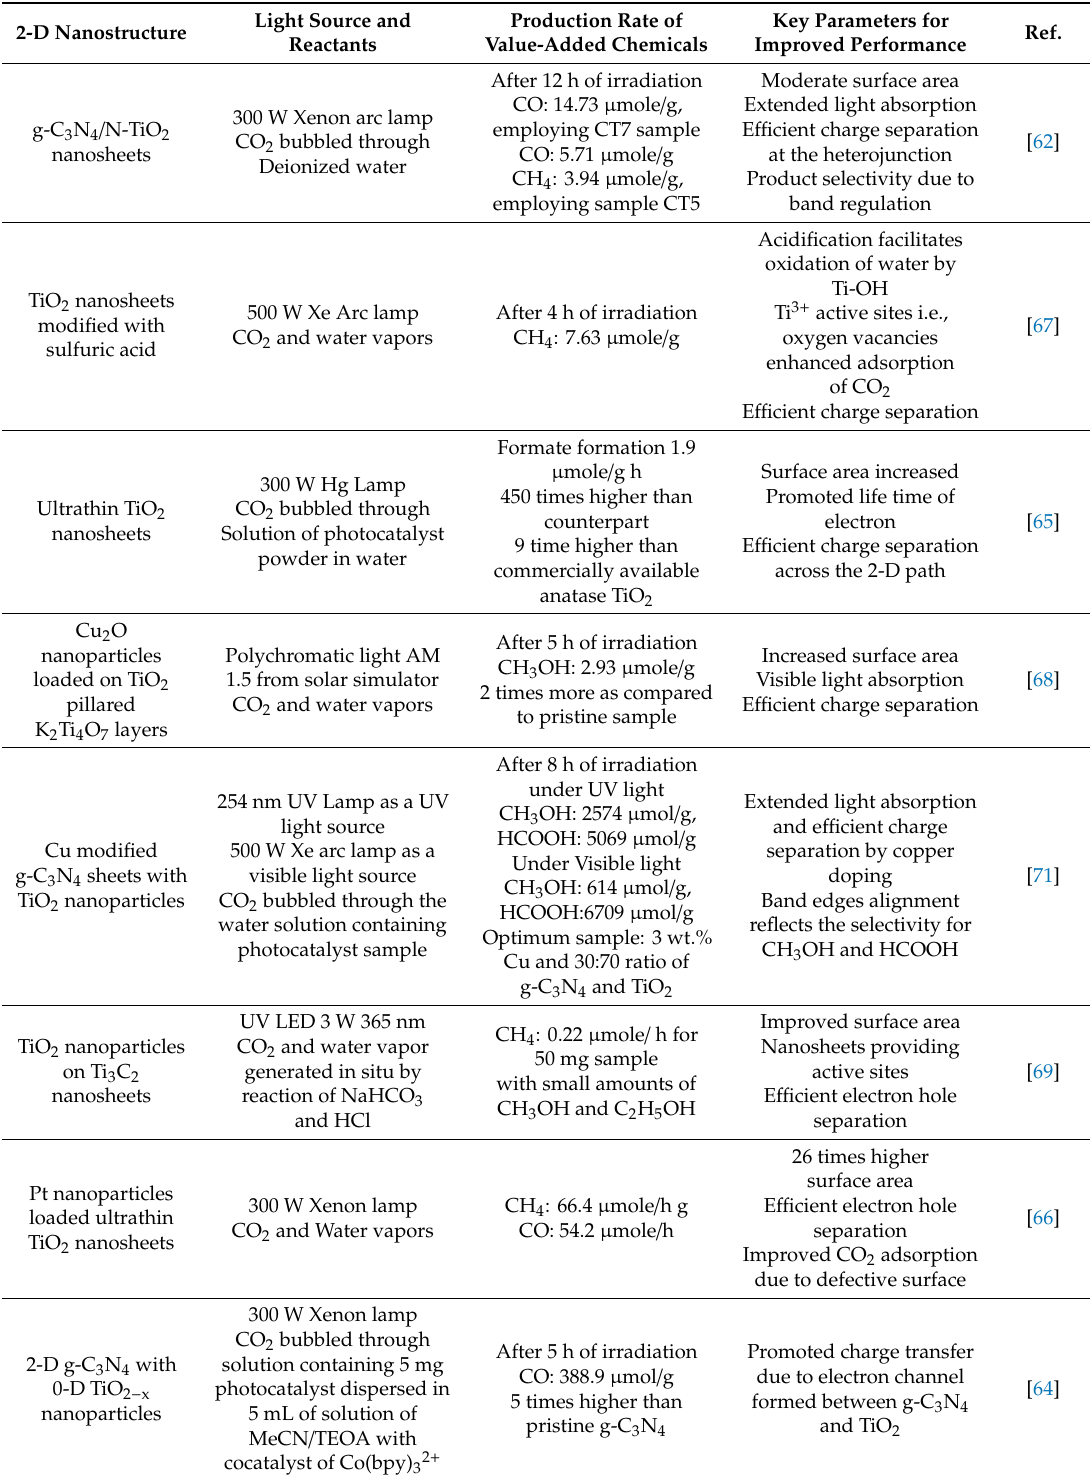
Table 3. Summary of various 2-D nanostructured photocatalysts with reaction conditions, value-added chemicals produced as a result of photocatalytic CO 2 conversion, and key parameters for improved